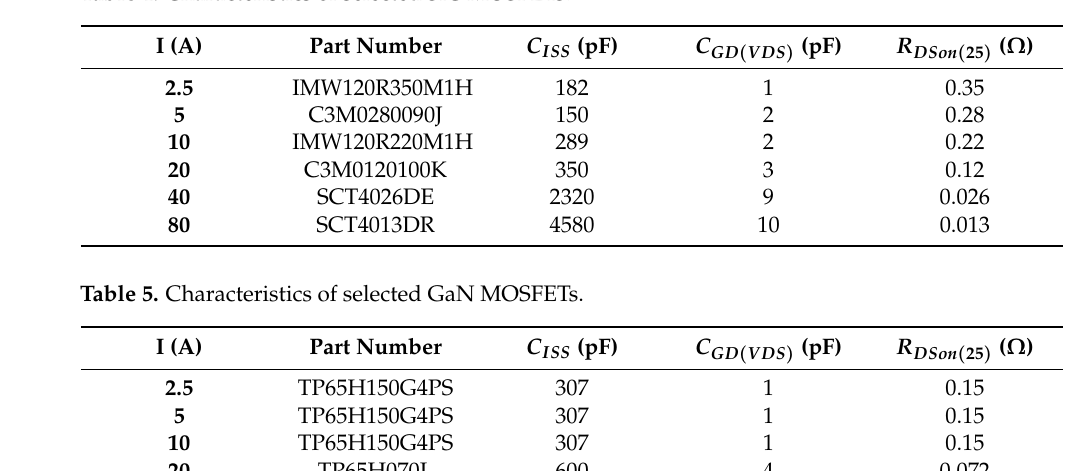
Table 4. Characteristics of selected SiC MOSFETs.